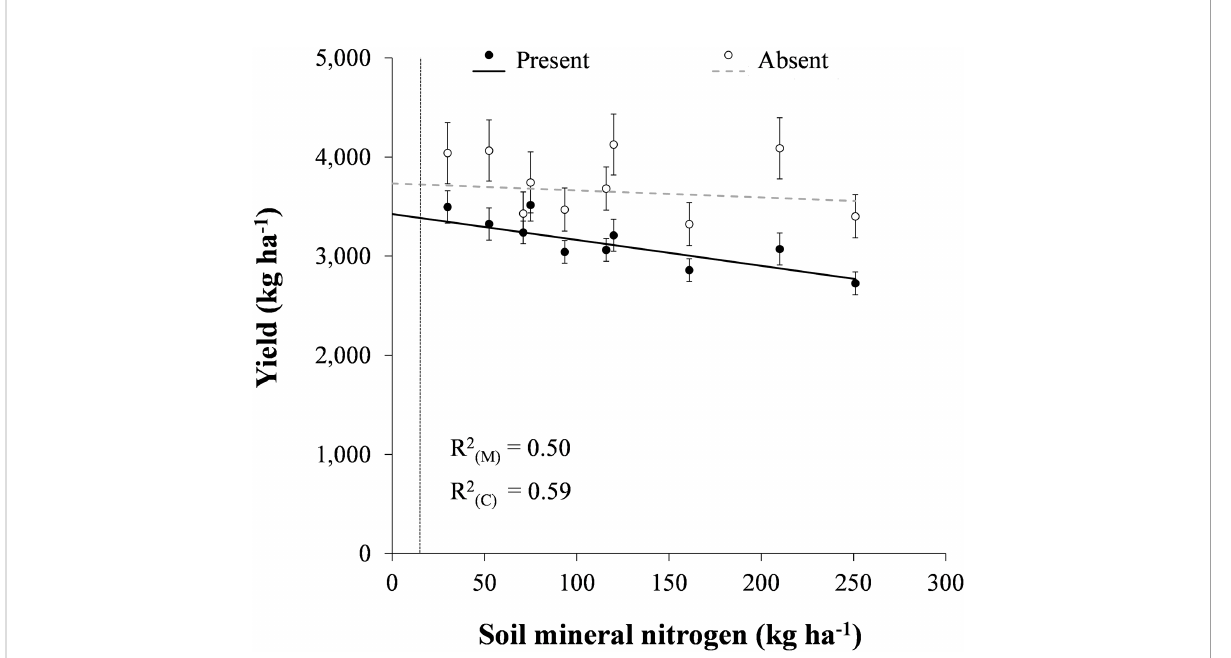
FIGURE 2 Soybean yield in response to soil mineral nitrogen in the presence and absence of volunteer canola. A signi fi cant difference ( a = 0.05) in soybean yield between the presence and absence of volunteer canola interference was found at soil mineral N levels greater than the vertical dissecting line (15 kg N ha -1 ). Dots indicate means of soybean yield for each level of soil mineral nitrogen in a combined analysis of volunteer canola populations and environments. Error bars indicate ± SEM. The black line indicates a signi fi cant linear component, while the grey line indicates lack of signi fi cant difference of the linear component from 0 ( a = 0.05). Marginal (R 2 (M) ) and conditional (R 2 (C) ) coef fi cients of determination are indicated for the entire linear mixed effects model. All model parameters are described in Supplementary Table